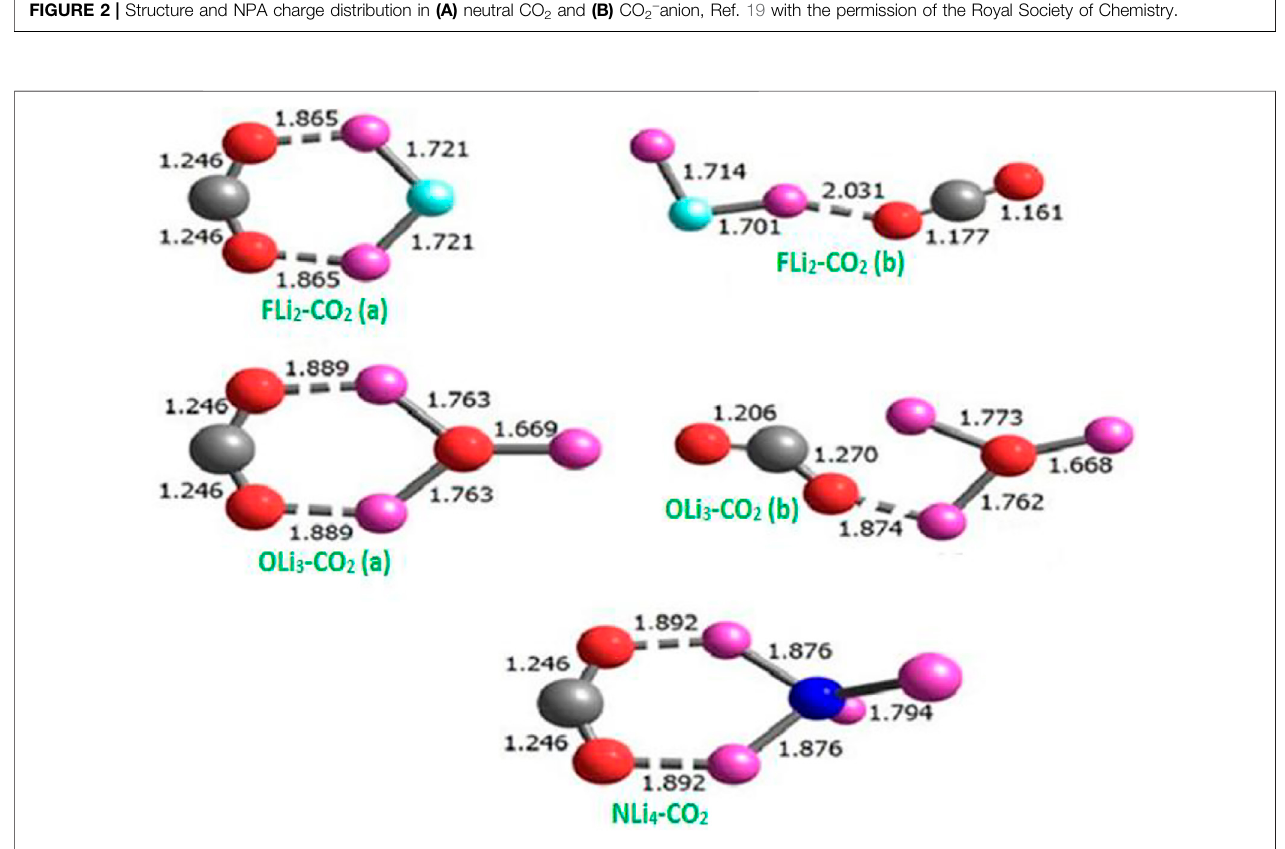
FIGURE 3 | Equilibrium structures of CO 2 complexes with typical superalkalis, with bond lengths in Å from Ref. 35 with the permission of Wiley.